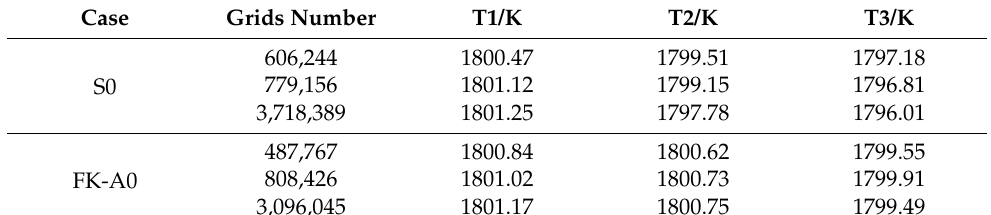
Figure 5. Location of the reference point: ( a ) channel exit section for S0 case; ( b ) “Channel out1” section for FK-A0 case. Table 4. Temperature of reference points with different grid numbers.